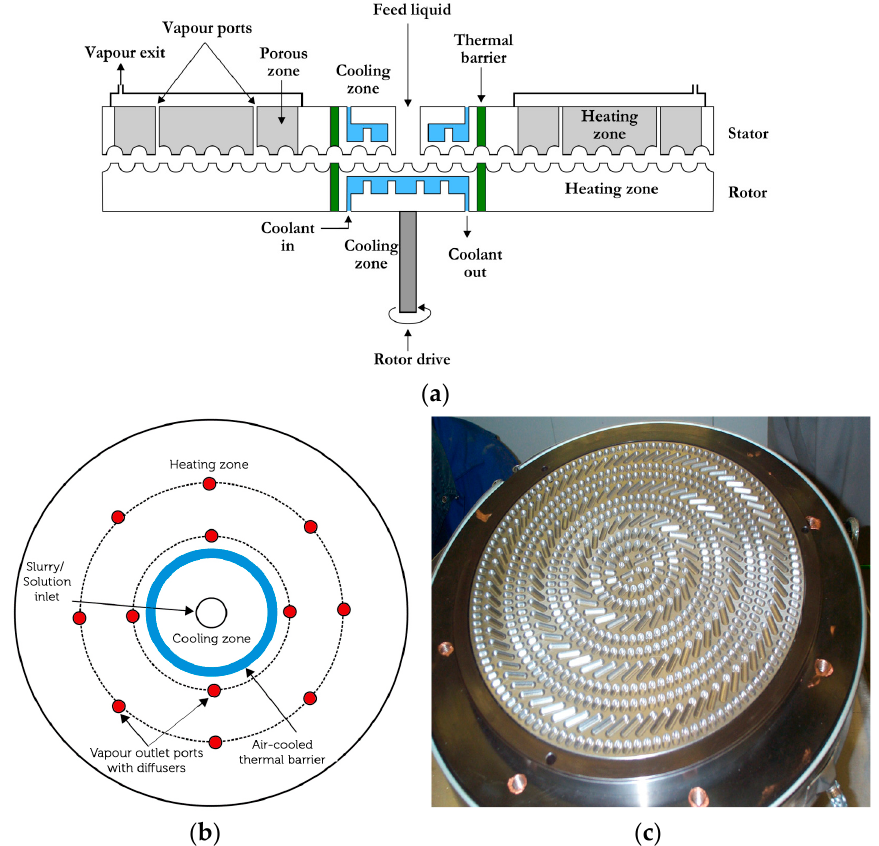
Figure 5. Equipment for the production of agglomerated dense catalysts. ( a ) Cross ‐ section of the rotor ‐ stator system with different functional regions; ( b ) Top view of the equipment illustrating location of various inlets and outlets; ( c ) Photograph of the rotor showing the cavity shape and distribution.